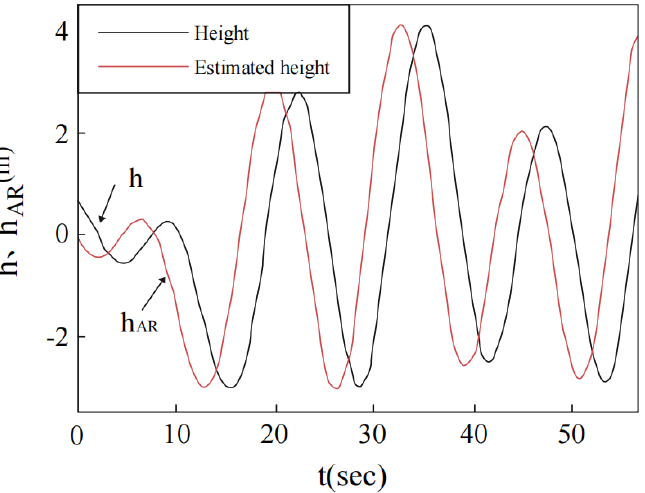
Figure 6. Height of ideal landing point and its estimated value (encounter angle of π /3, level − 5 sea state, navigation speed of 18 knots).